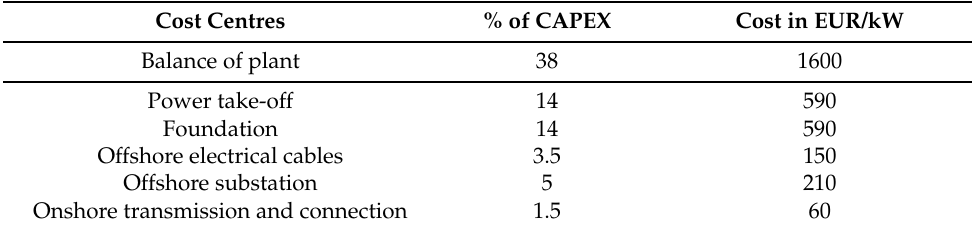
Table 7. A breakdown of costs for the Balance of plant costs based on [26] at the mid-term project (TRL